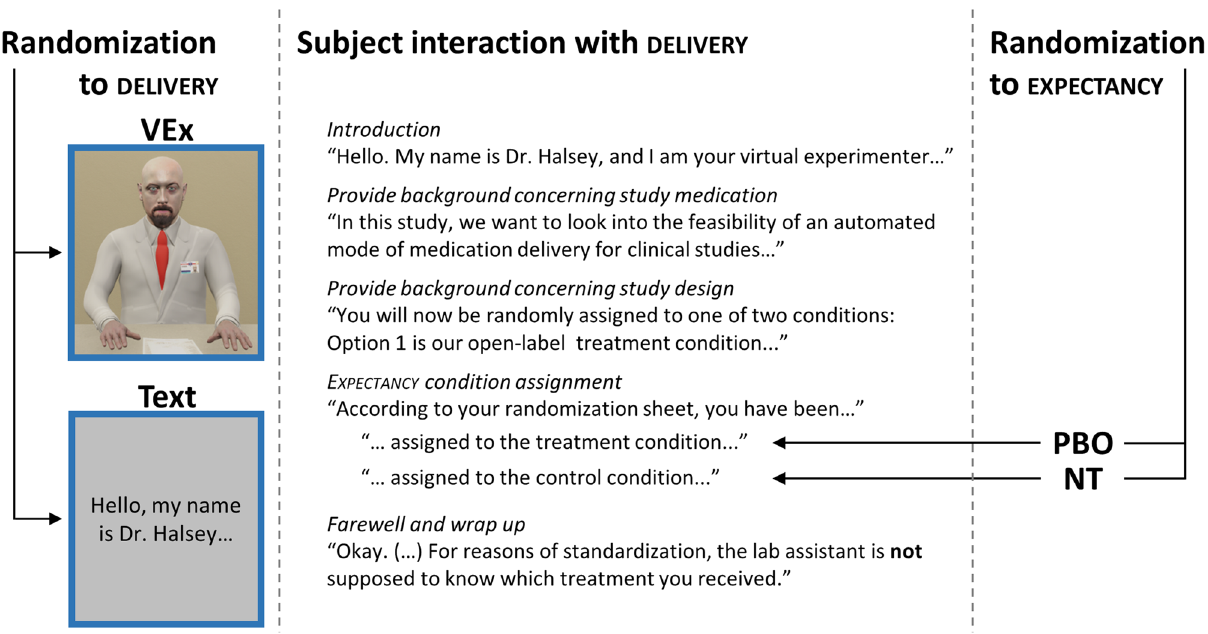
Figure 2. Treatment interaction with virtual experimenter or text/audio condition. Subjects randomly encountered either delivery condition. They then interacted with it (including confirmation of several sections, and option to ask FAQs). During the interaction, they were randomly assigned to either expectancy condition. Virtual experimenter screen captured in